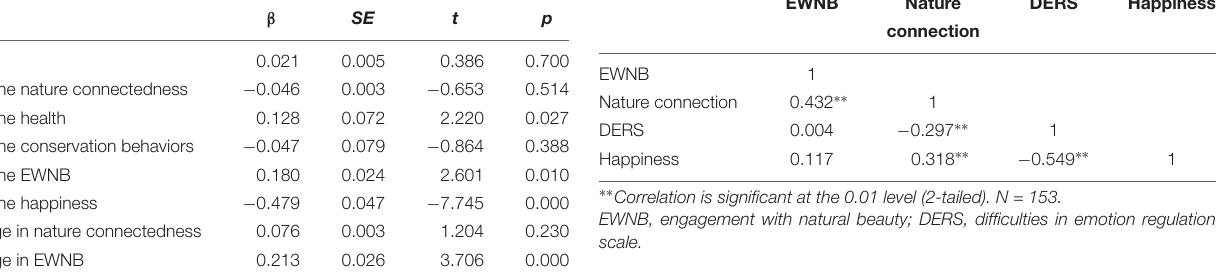
TABLE 7 | Correlation matrix for the supplementary